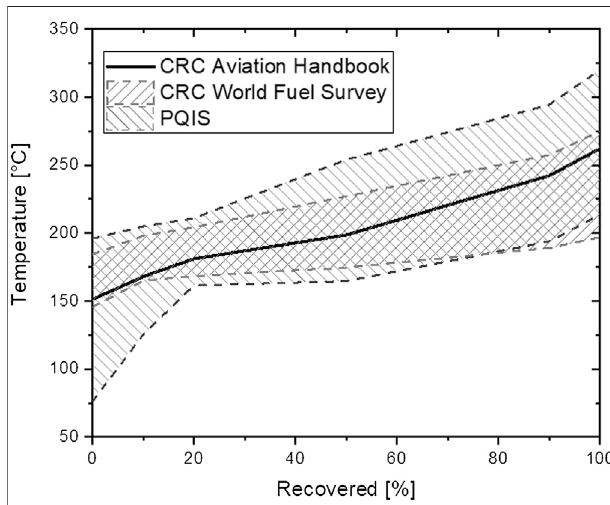
FIGURE1 | Comparison ofCRC Aviation Fuel Handbook typical Jet A-1 distillation vs range of data from CRC World Fuel Survey and